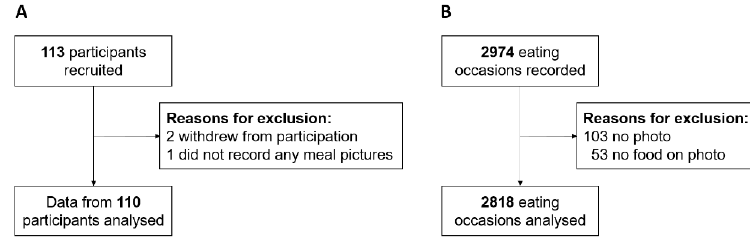
Figure 1. Flow diagram for ( A ) participants and ( B ) eating occasions.